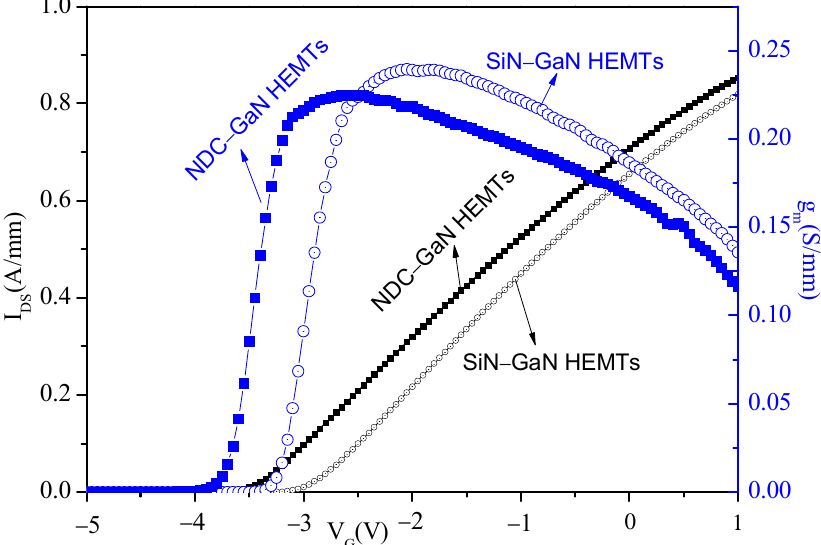
Figure 5. Transfer characteristic of GaN HEMTs with NDC and SiN passivated structure; the black curves represent transfer curves, and the green curves represent transconductance.